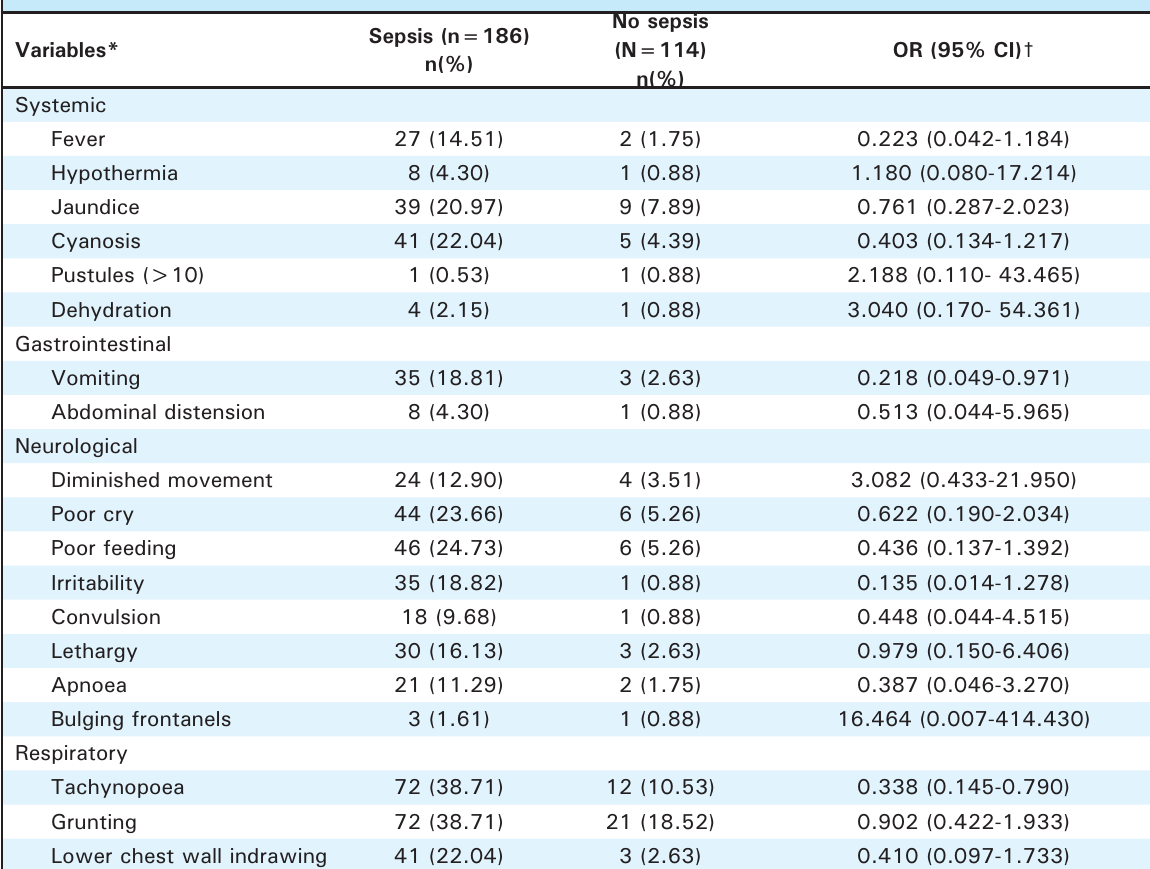
Table 2. Clinical presentations predicting neonatal sepsis.